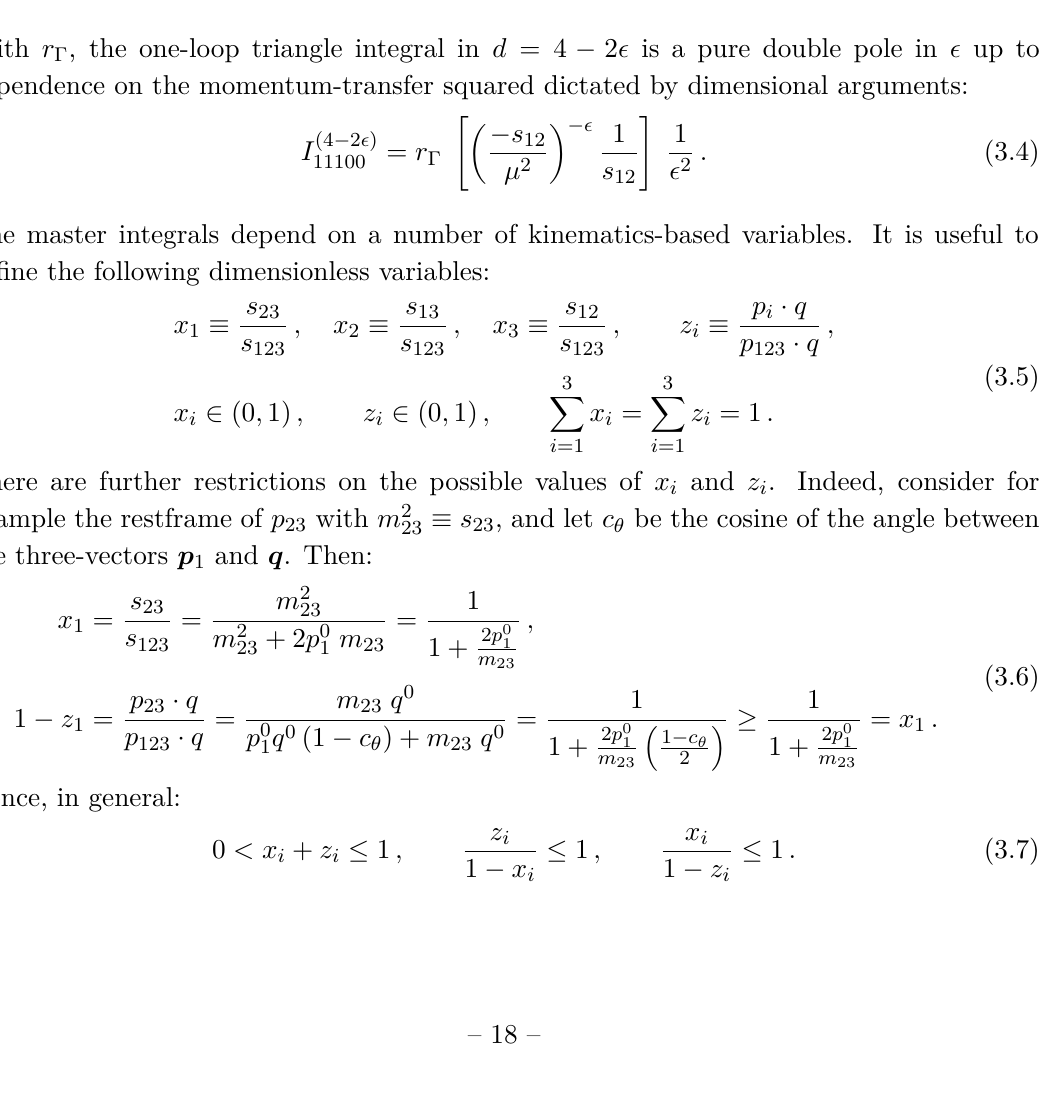
Figure 7 . Diagrammatic representation of the master integrals. Lines 1, 2 and 3 correspond to outgoing momenta p , p and p respectively. The thick incoming line is off shell with momentum 1 2 3 p 123 = p 1 + p 2 + p 3 . The red double-line corresponds to a linear (eikonal) propagator introduced through the use of the lightcone